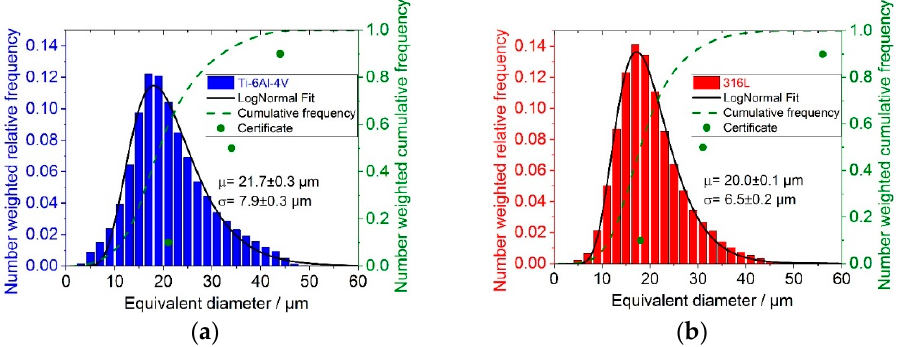
Figure 4. Particle size distribution and cumulative frequency (dashed line) of ( a ) Ti–6Al–4V powder batch and ( b ) 316L steel powder batch. Both distributions are fitted with a log–normal function (black line). The certificated value for D 10 , D 50 , and D 90 are presented as green dots. Table 1. Comparison of volume-weighted powder particle size distributions obtained by laser An additional method for size analysis was the PCA of grey value distribution of each particle [28]. diffraction (LD) and by